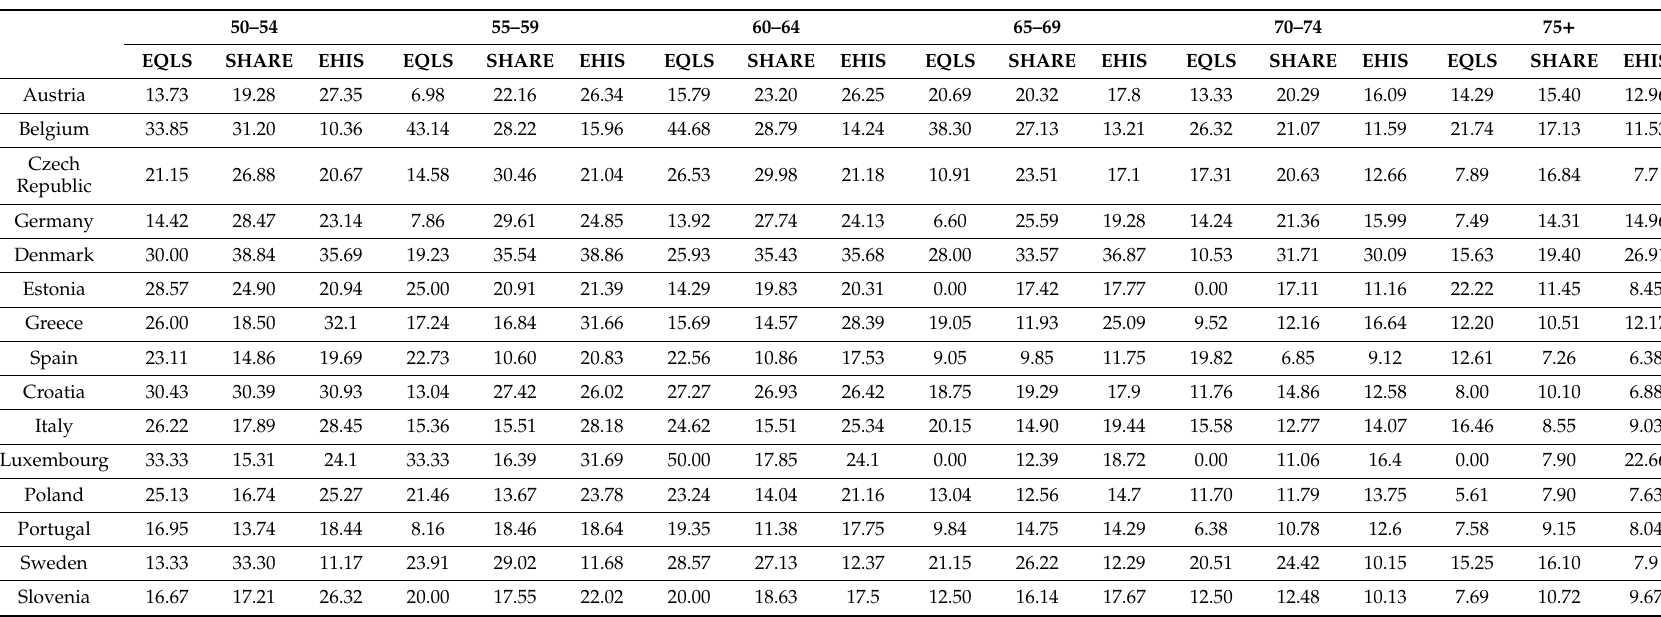
Table 4. Informal Caregivers over 50, by age group (weighted) (Small sample size regarding Slovenia, Estonia and Luxemburg; therefore results should be interpreted with